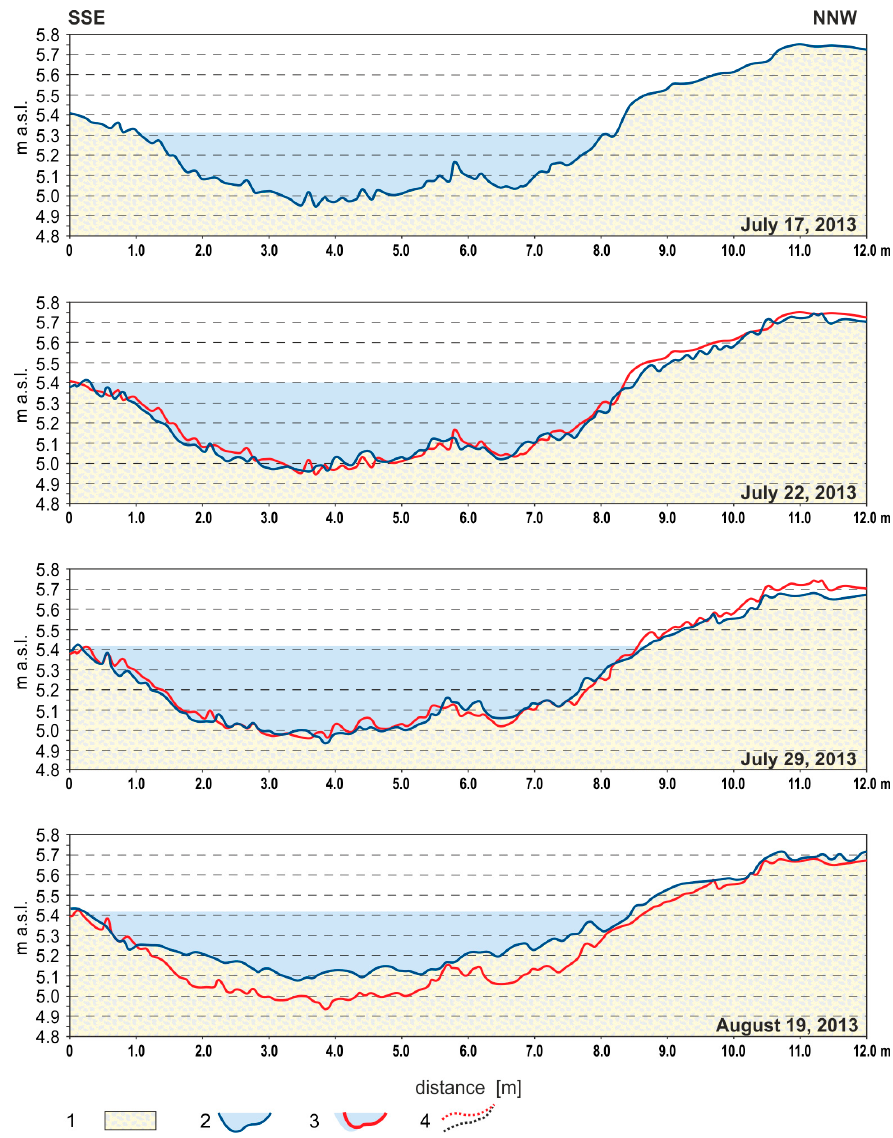
Figure 7. Changes in the channel bottom in XS I in 2013: 1. Bedrock, 2. Current stage, 3. Previous stage, 4. Dry streambank.